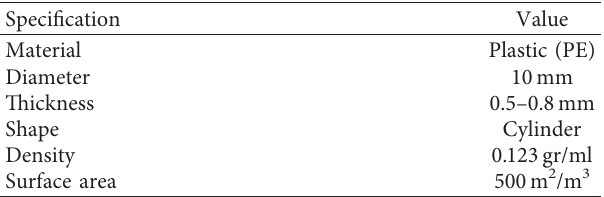
Figure 1: Diagrammatic representation of the overall setup of the An-SBR and MBBR. Table 1: Specification of Kaldnes K1 media